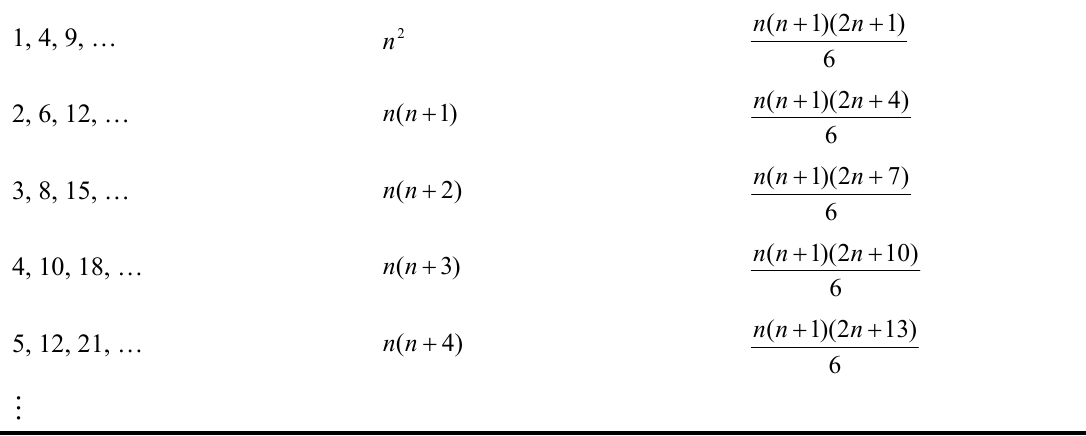
Figure 13 : A partial list of arithmetic processes reified as algebraic